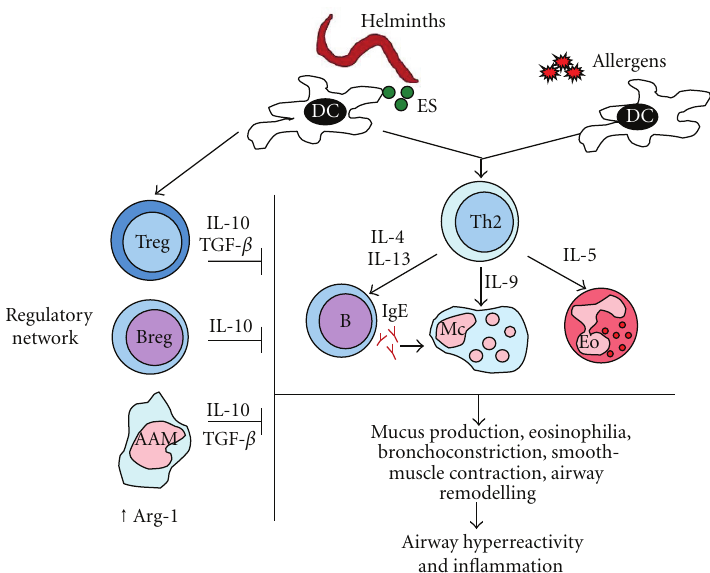
F 1: Mechanisms involved in immunosuppression induced by helminths and its effect on allergic responses. Helminths can modulate dendritic cells (DCs) function and induce regulatory T (Treg) cells. Other cells from the regulatory network include regulatory B (Breg) cells and alternatively activated macrophages (AAMs). ese cells create an immunosuppressive ( of arginase 1 (Arg 1) in AAMs and the production of the cytokines IL-10 and TGF-